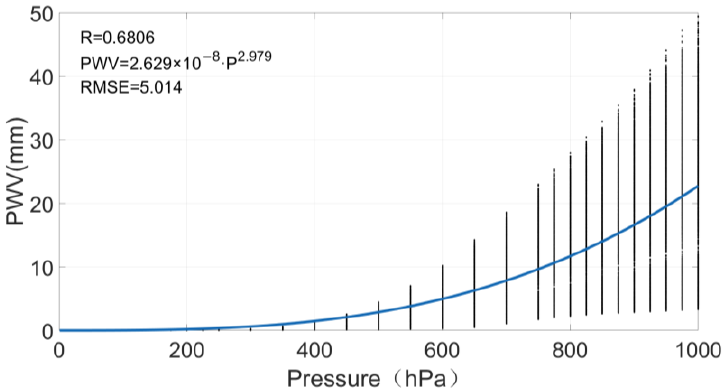
Figure 4. Variation relation between PWV and pressure.